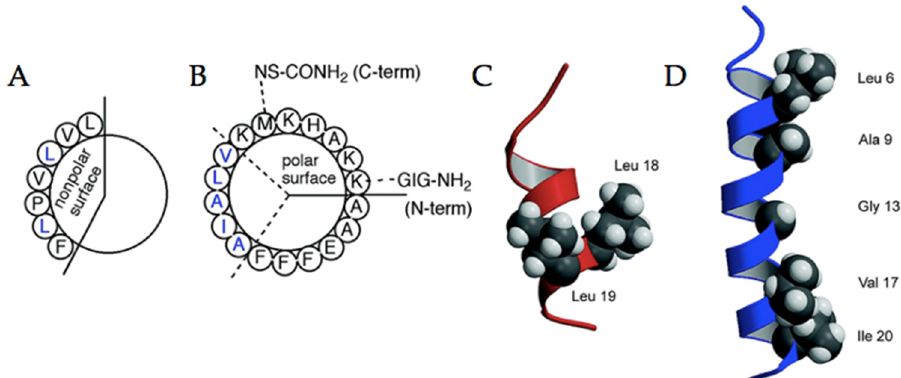
Figure 12. Helical wheel diagrams and sites of fluorination. ( A ) Buforin series: Leu 18 and 19 (blue) were substituted with HFL; ( B ) magainin series sites of fluorination: residues Leu 6 and Ile 20 in M2F2 and Leu 6, Ala 9, Gly 13, Val 17, and Ile 20 in M2F5; ( C ) Model structure of buforin with Leu 18 and 19 shown in space-filling depiction; ( D ) NMR-determined structure of magainin in dodecylphosphocholine micelles. Reprinted with permission from [70]. Copyright 2007 American Chemical Society.